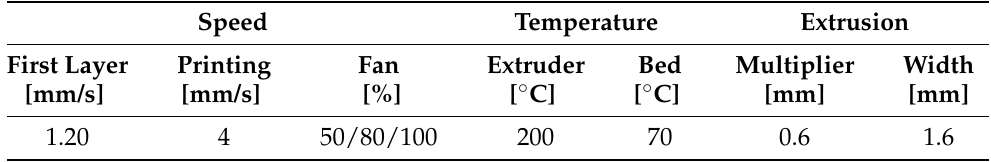
Table 1. Parameters used for fabricating the sample